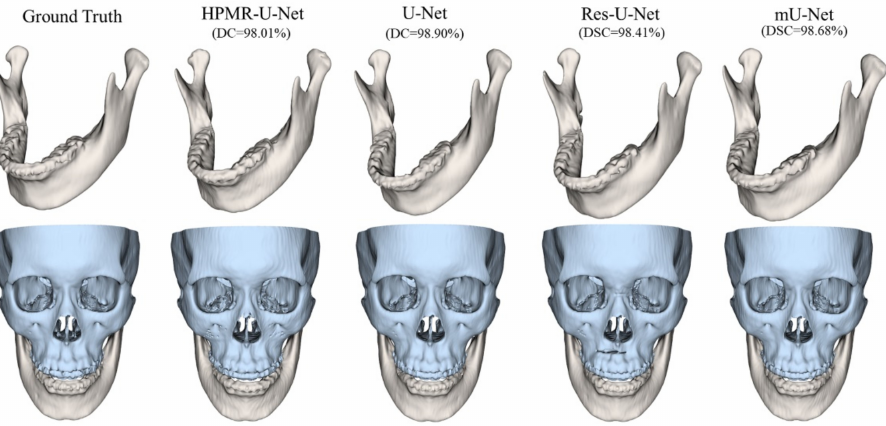
Figure 5. Sample case in the CenterA dataset. White and blue indicate the mandible and maxilla, respectively.